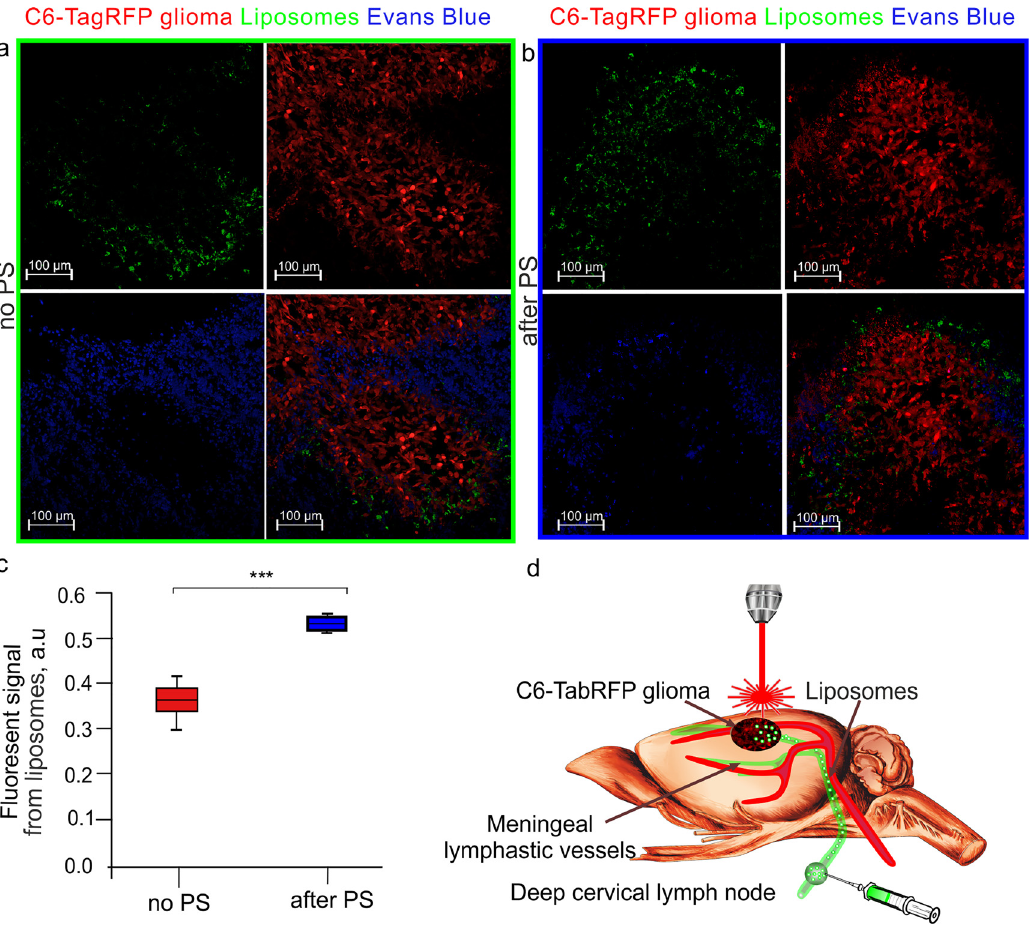
Figure3: Thephotostimulation(PS)oflymphaticdeliveryofliposomestoglioma: a and b – RepresentativeimagesofliposomesandtheEvans Blue fl uorescence in the glioma tissues in the untreated group (a) and the group treated by PS (b); с – Quanti fi cation of the intensity of the fl uorescent signal from liposomes in the brain of treated and untreated rats by PS, *** p < 0.001 between groups, n = 7 in each group; d – Schematic illustration of the experimental